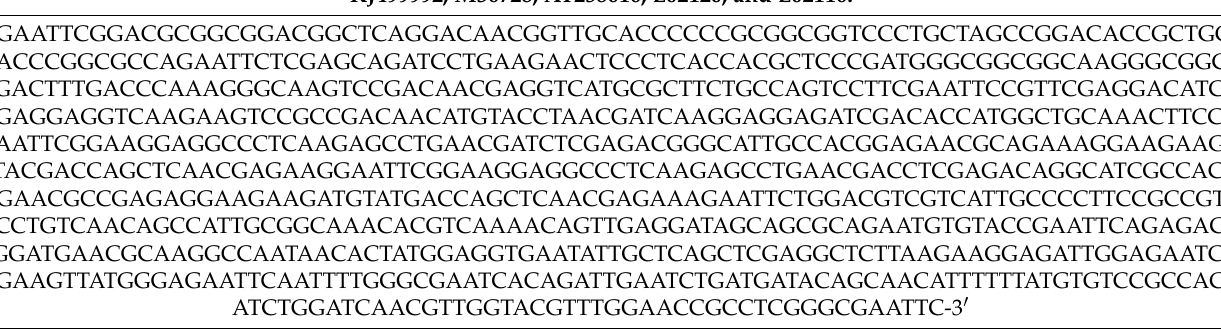
Table A3. Sequence insert of the positive control plasmid.